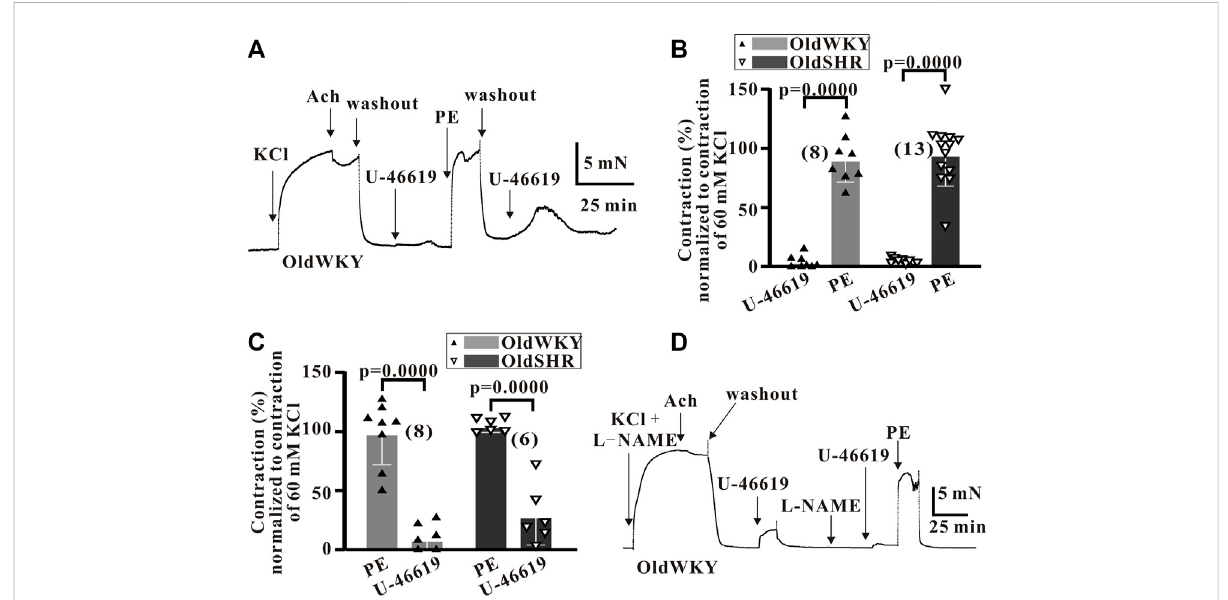
FIGURE 3 U-46619 and PE induced the contraction of endothelium-denuded mesenteric artery rings. (A) Typical recordings showing vessel response to 1 μ M U-46619 and 5 μ M in OldWKY rats, showing that the artery with impaired response to U-46619 had normal response to phenylephrine. (B,C) Summary data showing that vessels with reduced response to U-46619 in OldWKY and OldSHR rats had normal response to PE, showing similar results regardless of whether U-46619 or PE was used fi rst. (D) Typical recordings showing vessel response to 1 μ M U-46619 and 5 μ M in OldWKY rats after the preconditioning of L-NAME, indicating that the artery with impaired response to U-46619 was not due to incomplete endothelial removal. Numbers inserted in the graphs represented the number of arteries used in the experiment. Arteries were obtained from 4 – 6 rats in each